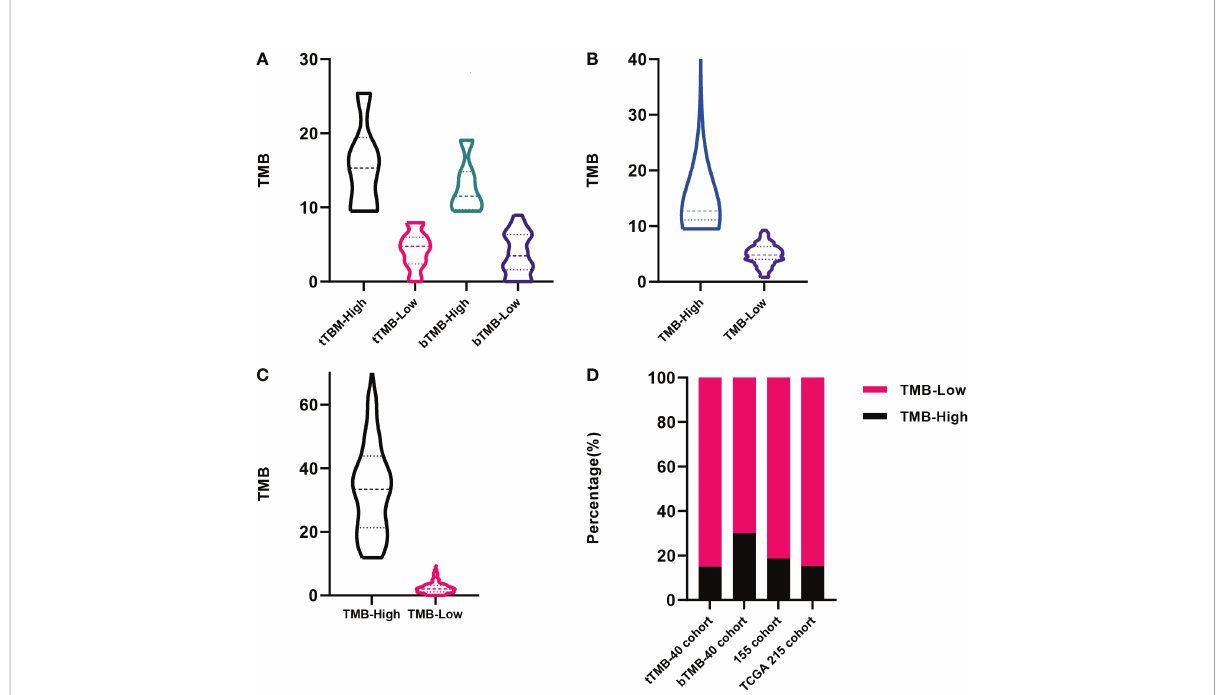
FIGURE 1 The distribution of tumor mutation burden (TMB) among patients. (A) Forty patients receiving fi rst-line chemotherapy in our cohort tested by tissue samples and blood samples. (B) Patients included in our 155 cohort. (C) Patients recorded in The Cancer Genome Atlas (TCGA) database. (D) The proportion of patients among the above cohorts according to TMB status.